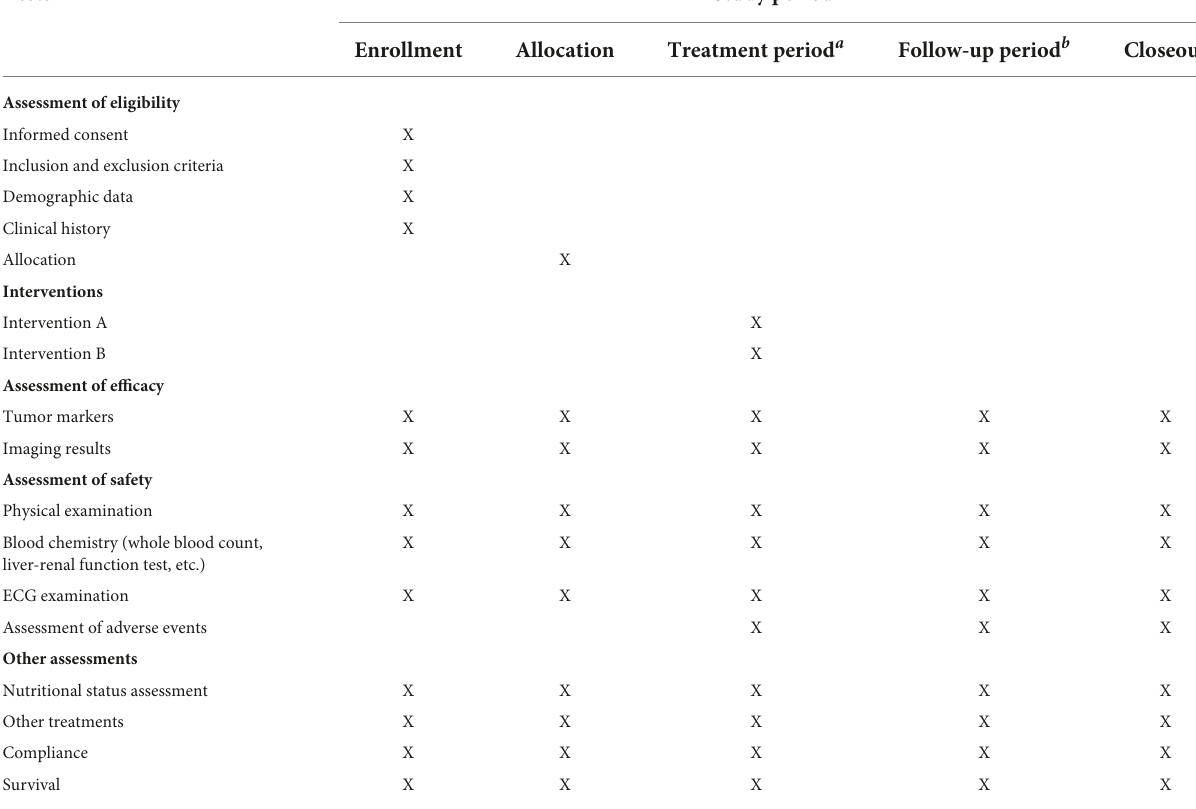
TABLE 1 SPIRIT figure showing time points for enrollment, interventions, and